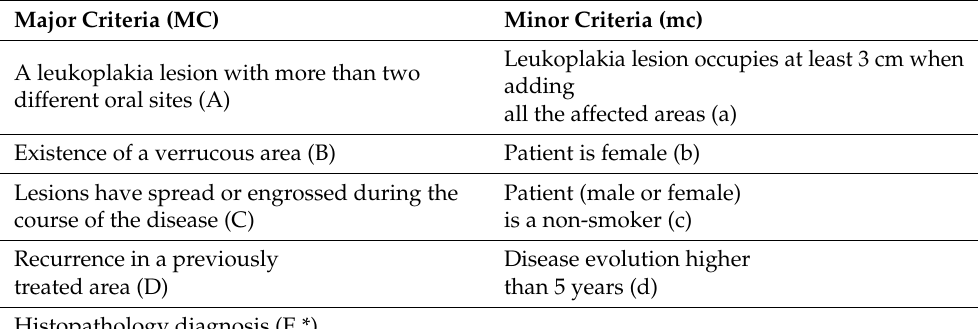
Table 1. Proposed criteria for proliferative verrucous leukoplakia (Cerero-Lepiedra et al. [15]). Major Criteria